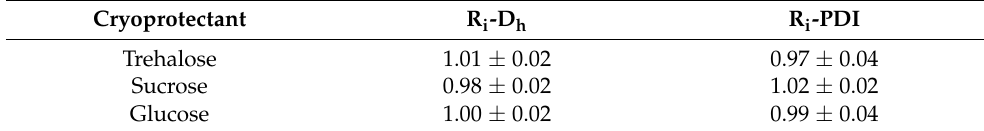
Table 2. Change factors (R i ) of mean D h and PDI upon adding 1% m/v cryoprotectant ( n ≥